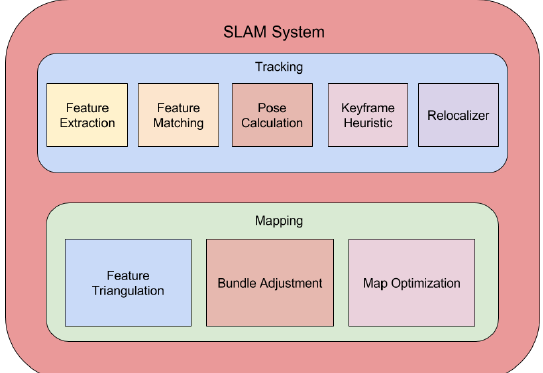
Figure 5: Overview of the SLAM module implemented on the smartphone device fir the real-time estimation of camera poses and sparse point